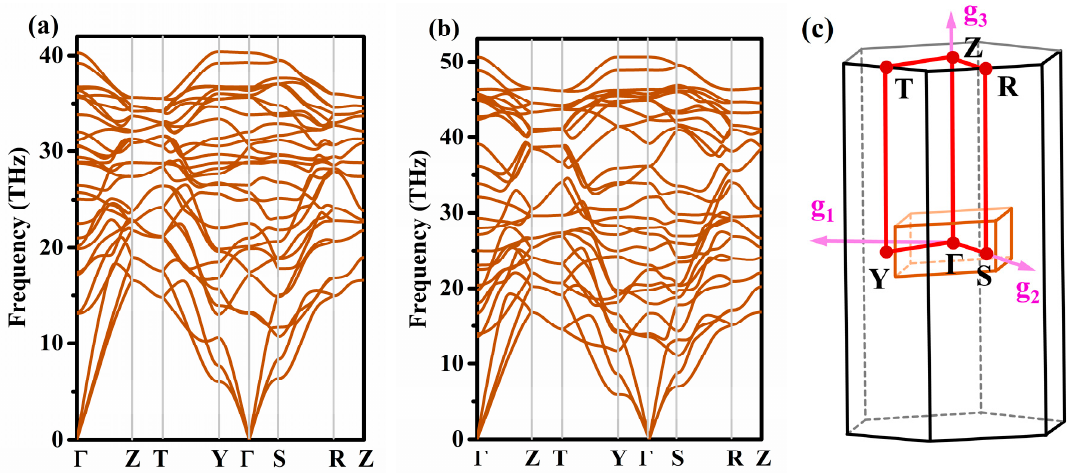
Figure 3. The phonon spectra of Penta-C 20 under ( a ) 0 GPa and ( b ) 100 GPa, and the coordinates of the high symmetry points in the Brillouin zone of Penta-C 20 ( c ).